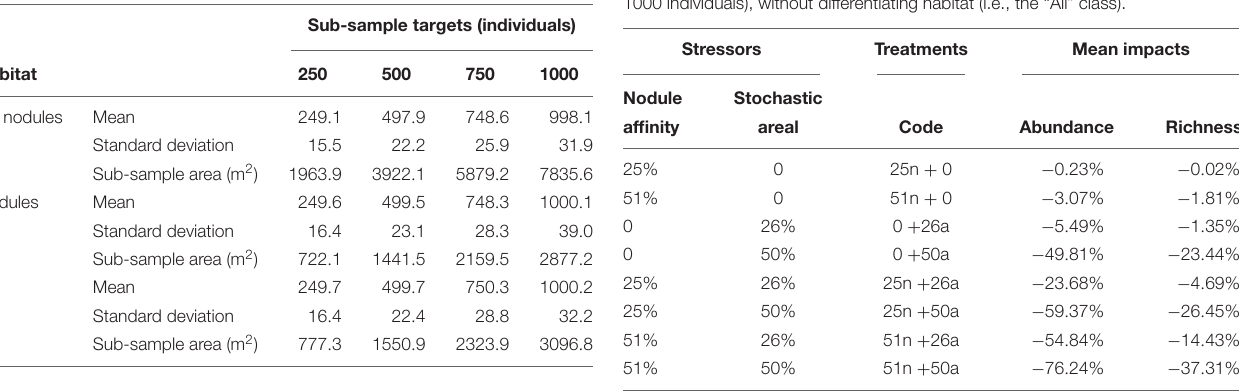
TABLE 2 | Mean number of individuals, standard deviation, and mean area of sub-samples, across 2000 randomisations.